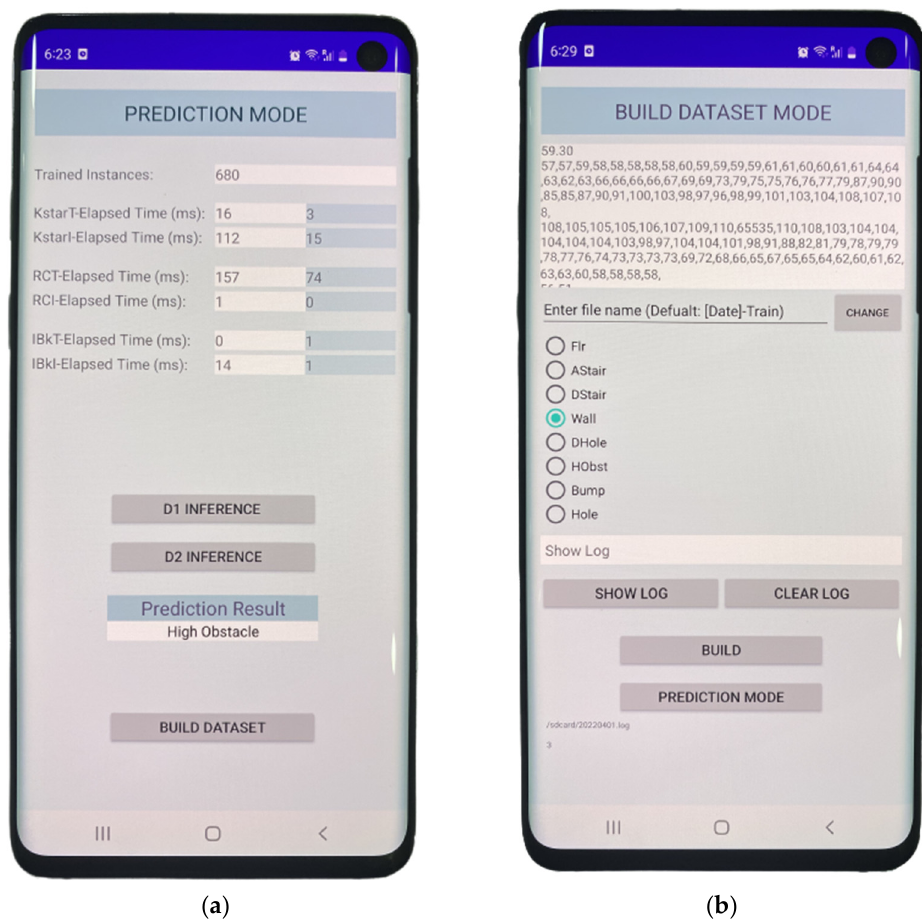
Figure 13. LidSonic V2.0 App. ( a ) Prediction Mode. ( b ) Build Dataset Mode.